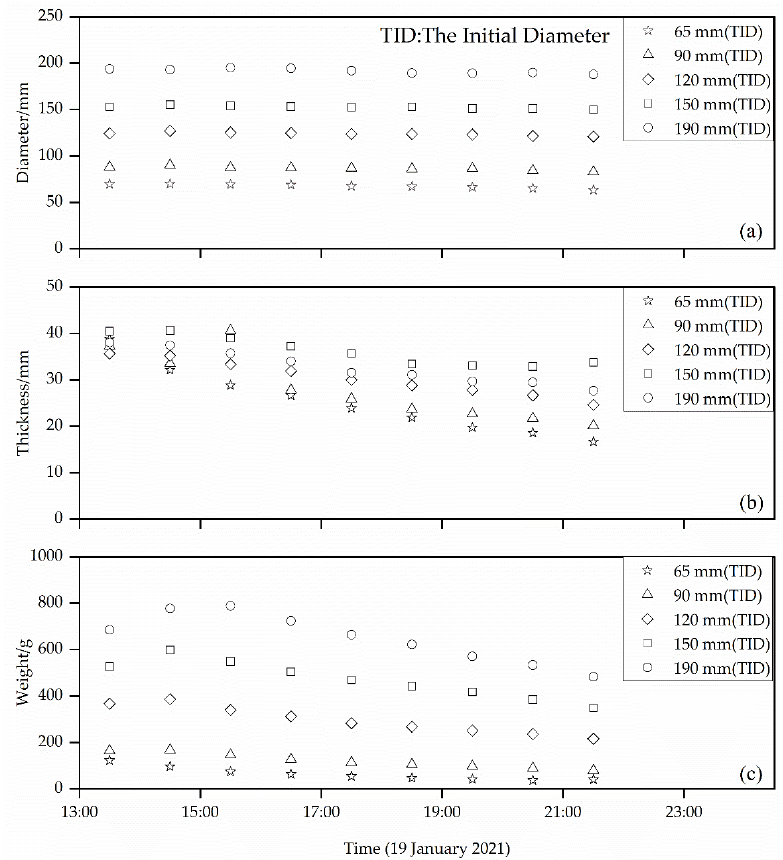
Figure 6. ( a ) Diameter, ( b ) thickness, and ( c ) mass variability of the tested sea ice samples at the designed preliminary water temperature of 1.0 ° C.